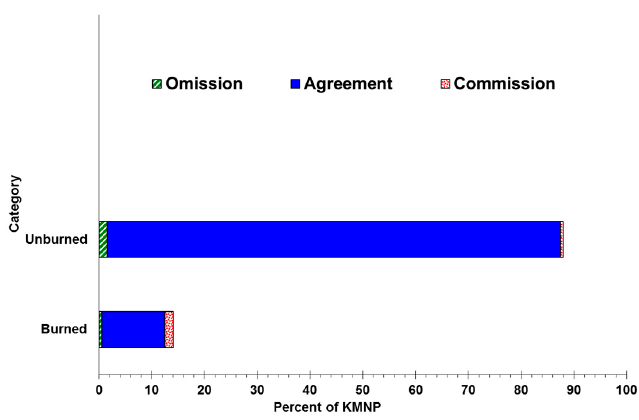
Figure 3. Category level analysis of agreement, omission disagreement and commission disagreement for burn classification. Land cover categories are on the vertical axis while the reference pixels are on the horizontal axis.